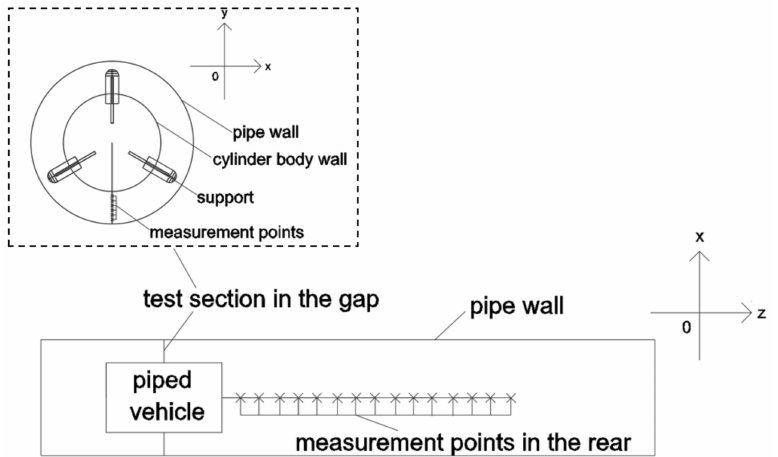
Figure 6. Layout of the test section, test lines, and measurement points for gap flow and rear flow.